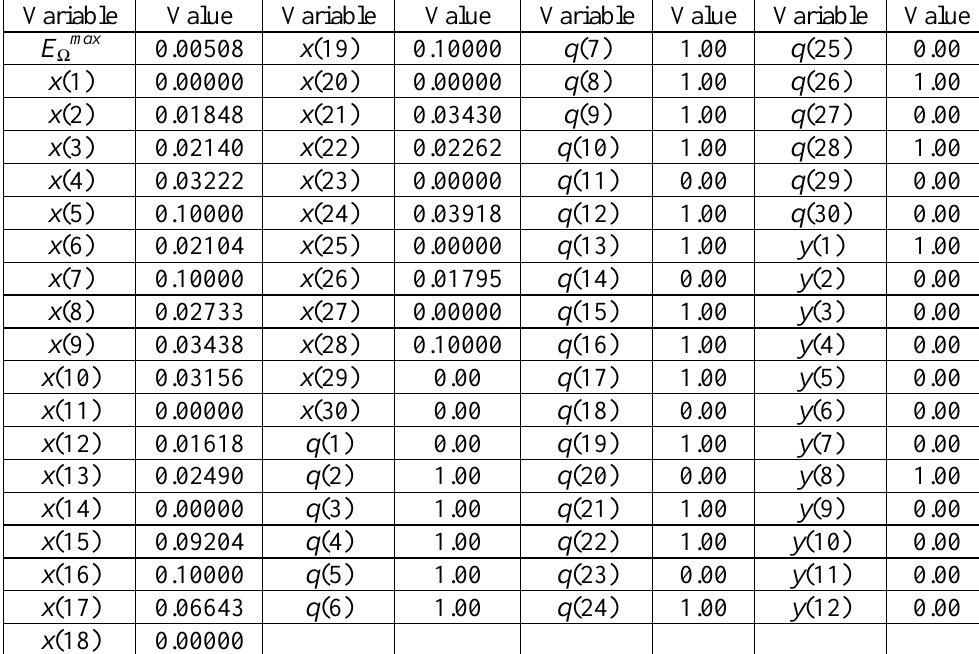
Table 8. Obtained values of decision variables using